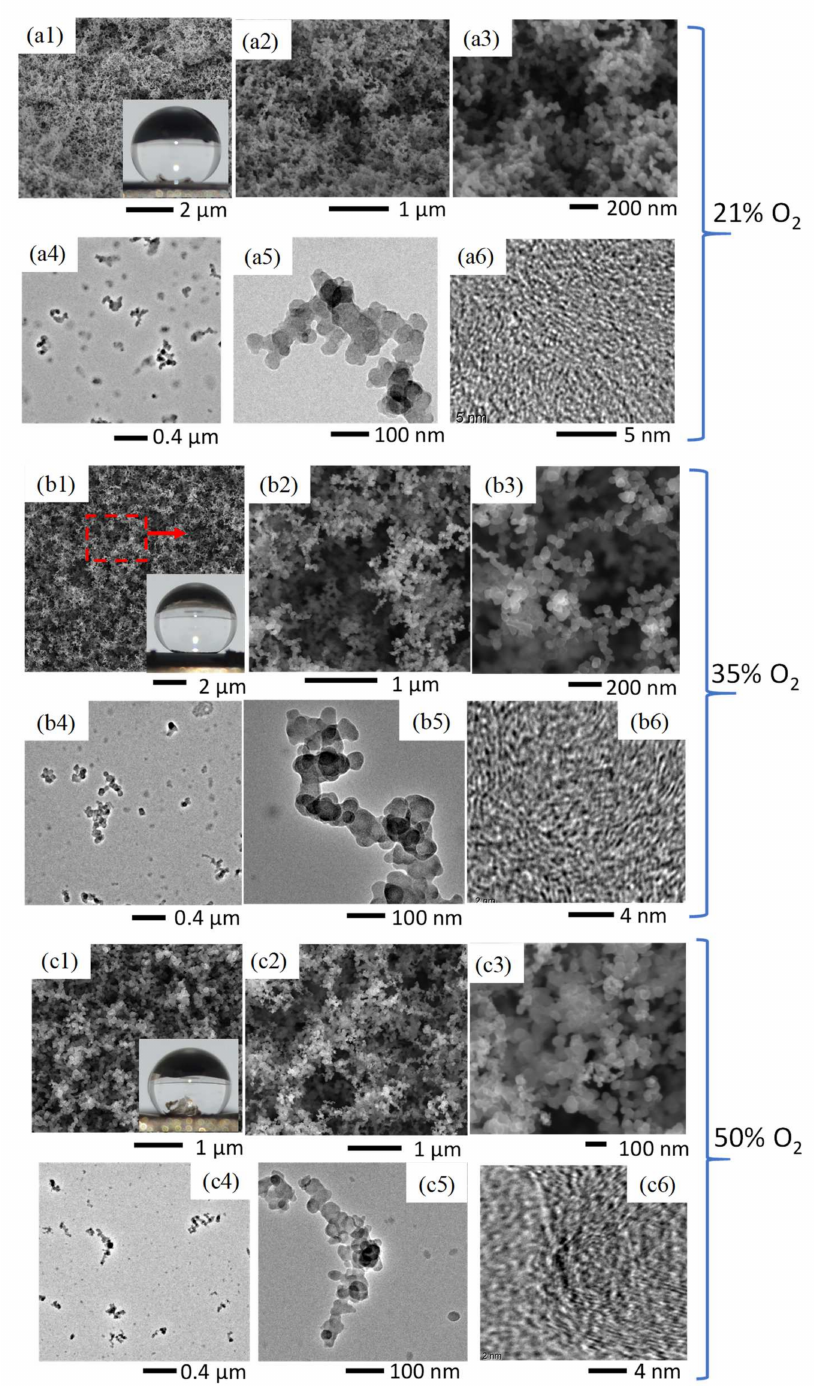
Figure 4. Comparative SEM images of C-layers formed in a CME/air flame ( a1 – a3 ), CME/35% O 2 flame ( b1 – b3 ), and CME/50% O 2 flame ( c1 – c3 ). TEM images of soot collected at the respective flame insertion heights of the substrate for the CME/air flame ( a4 – a6 ), CME/35% O 2 flame ( b4 – b6 ), and CME/50% O 2 flame ( c4 – c6